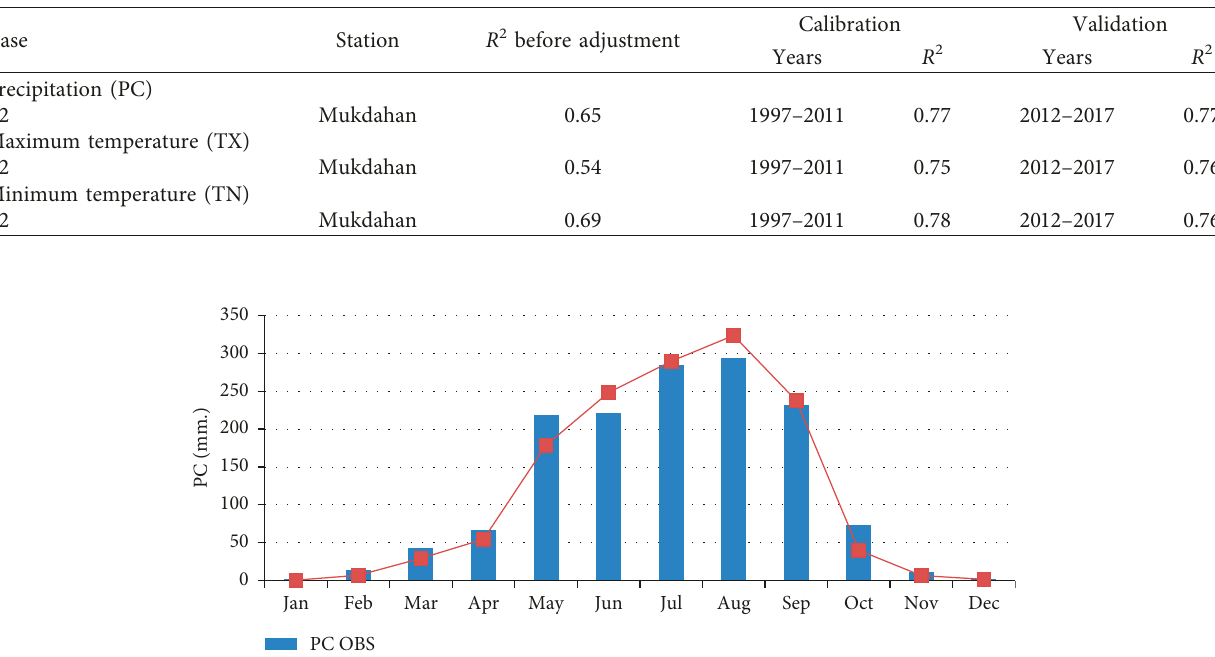
Table 10: R 2 of climate scenarios.